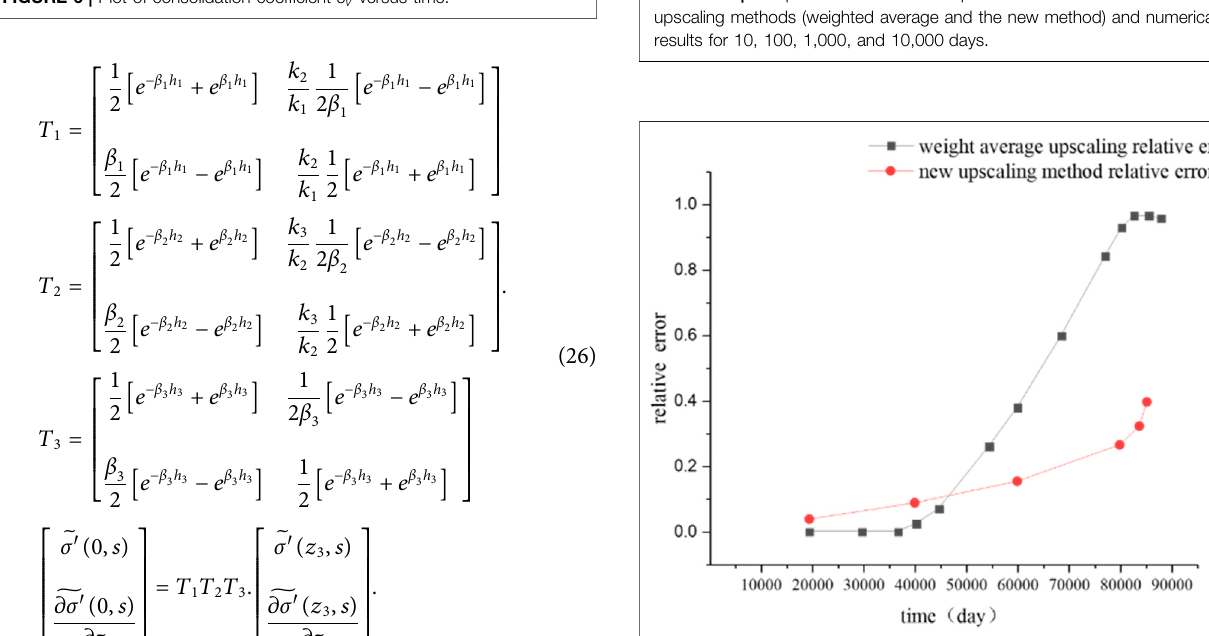
FIGURE 8 | Plot of relative error change with time for weighted average upscaling and the new upscaling